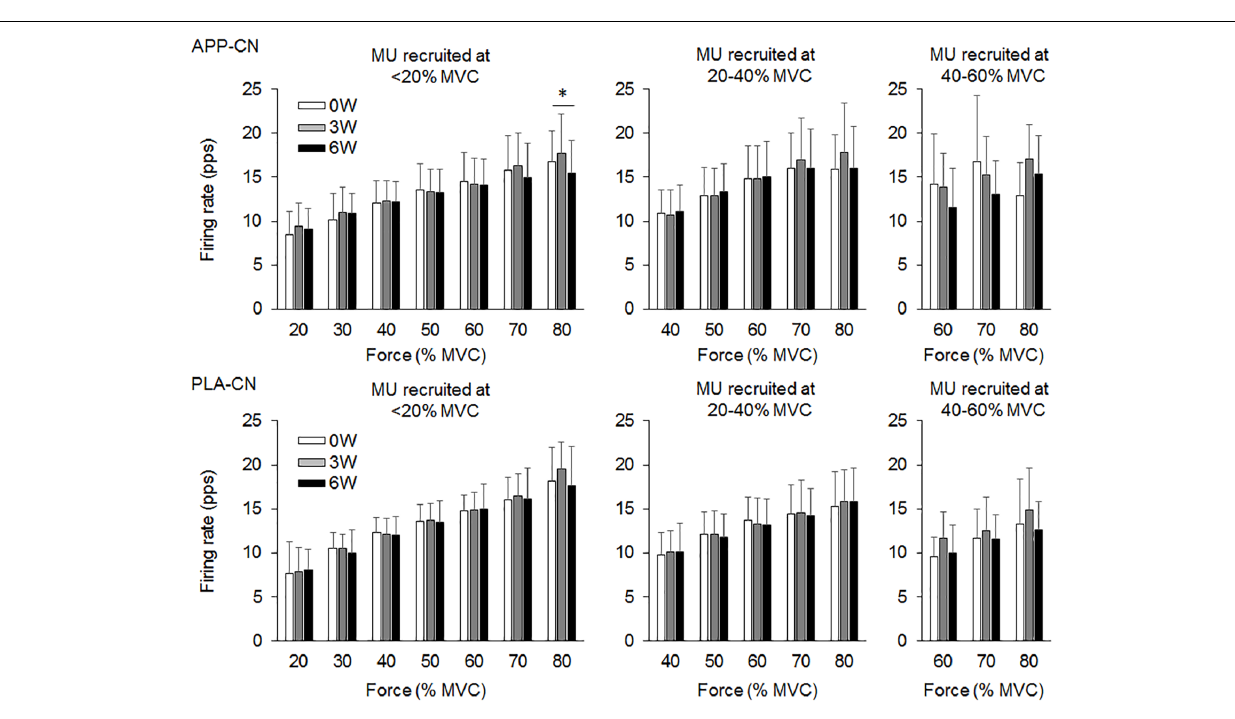
vasti muscles (Vila-Cha et al., 2010). This supports our results. On the other hand, Kamen and Knight (2004) showed that a 6-week resistance training did not lead to a significant